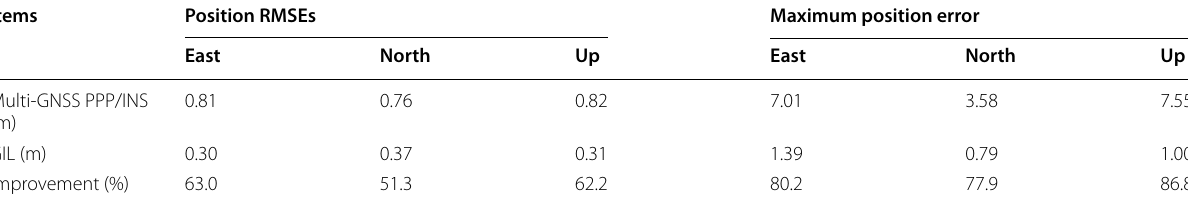
Table 4 RMSEs and maximum error of position for multi-GNSS PPP/INS and GIL solutions in GNSS partly-blocked experiment Items